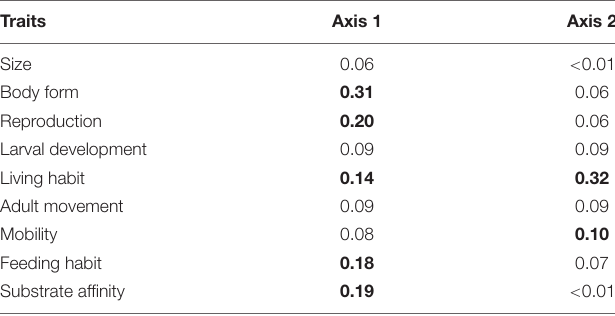
TABLE 3 | Correlation ratios of each biological trait on the first two axes of the fuzzy correspondence analysis for ROV samples of epibenthos in the Chukchi